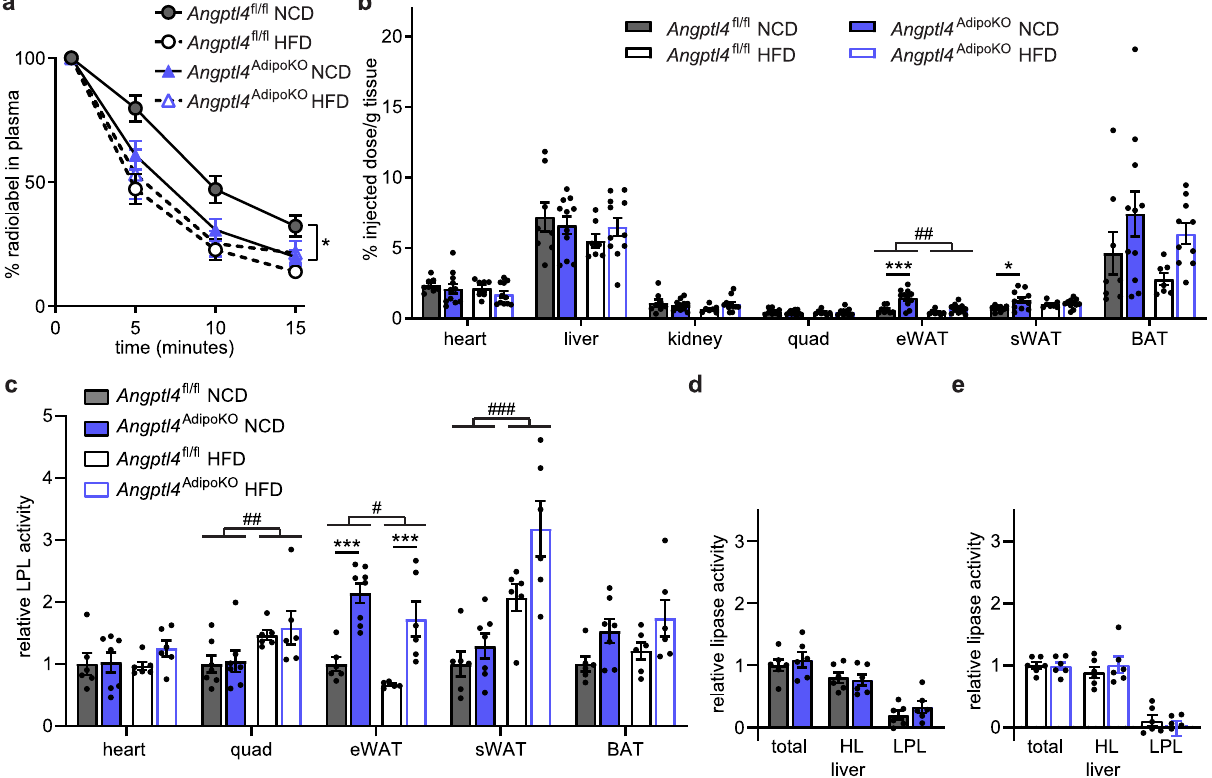
Figure 3. Chylomicron clearance and uptake and lipase activity in Angptl4 AdipoKO mice. ( a , b ) At the conclusion of 12 weeks of either normal chow diet (NCD) or high fat diet (HFD) Angptl4 fl/fl and Angptl4 AdipoKO male mice (n = 7–10/group) were fasted (6 h) and injected intravenously with 3 H-triglyceride–containing chylomicrons. ( a ) Clearance of radiolabel from the plasma 1, 5, 10, and 15 min after injection. Points represent percentage of radiolabel remaining in the plasma at the indicated time points compared to the 1-min time point (mean ± SEM). *p < 0.05 by repeated measures ANOVA. ( b ) Uptake of radiolabel (% injected dose/g tissue) into the indicated tissues after 15 min (mean ± SEM). ##p < 0.01 for dietary differences by two-way ANOVA. *p < 0.05, ***p < 0.001 for individual genotype-specific differences by multiple comparison after two-way ANOVA (Tukey correction). ( c ) Heart, quadricep muscle (quad), epididymal adipose tissue (eWAT), subcutaneous adipose tissue (sWAT), and brown adipose (BAT) tissue from fasted (6 h) male Angptl4 fl/fl and Angptl4 AdipoKO mice were harvested and lipase activity was measured (n = 6–8/group). ( d , e ) Liver was harvested from fasted (6 h) male Angptl4 fl/fl and Angptl4 AdipoKO mice (d, NCD groups and e, HFD groups) (n = 6/group). Lipase activity was measured in the presence or absence of 1 M NaCl to distinguish between hepatic and lipoprotein lipase. Bars show relative lipase activity in each tissue normalized to Angptl4 fl/fl (mean ± SEM). #p < 0.05, ##p < 0.01, ###p < 0.001 for dietary differences by two-way ANOVA. ***p < 0.001 for individual genotype-specific differences by multiple comparison after two-way ANOVA (Tukey